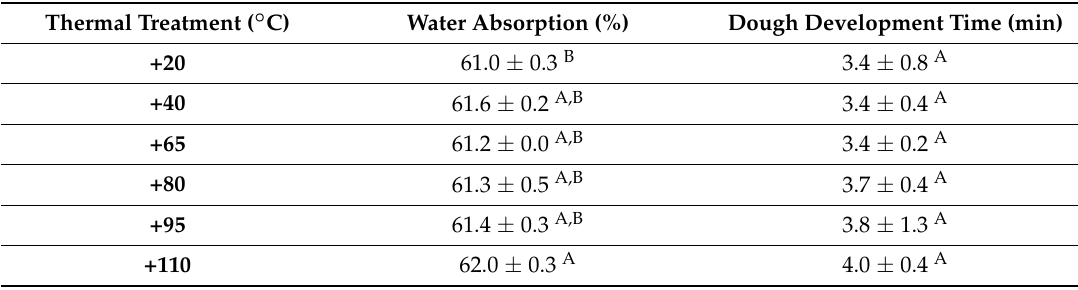
Table 2. Mean ( ± SD) dough water absorption and dough development time of thermally treated Table 2. Mean (± SD) dough water absorption and dough development time of thermally treated wheat flour determined by a Z-kneading system. SD = standard deviation; n = 3. wheat flour determined by a Z-kneading system. SD = standard deviation; n = 3.